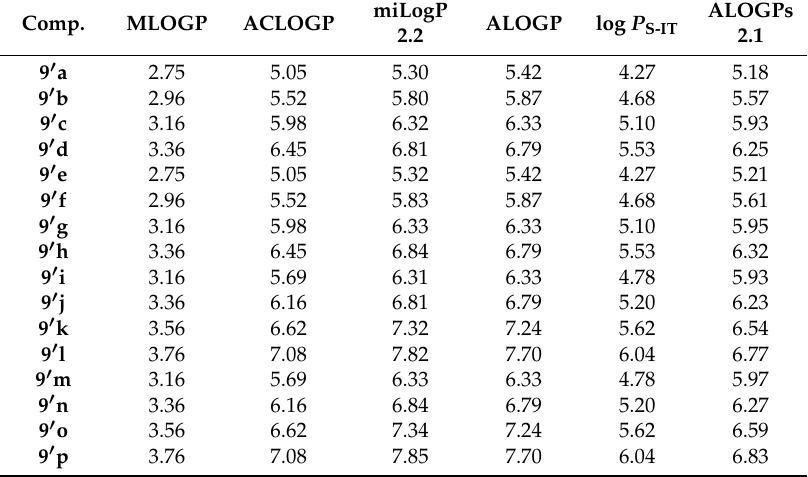
Table 5. Values of logarithms of partition coefficients of basic (non-protonated) compounds 9 ′ a – p predicted for the octan-1-ol/water partitioning system by the MLOGP, ACLOGP, miLogP 2.2, ALOGP, SILICOS-IT (log P S-IT ) and ALOGPs 2.1 method, respectively.